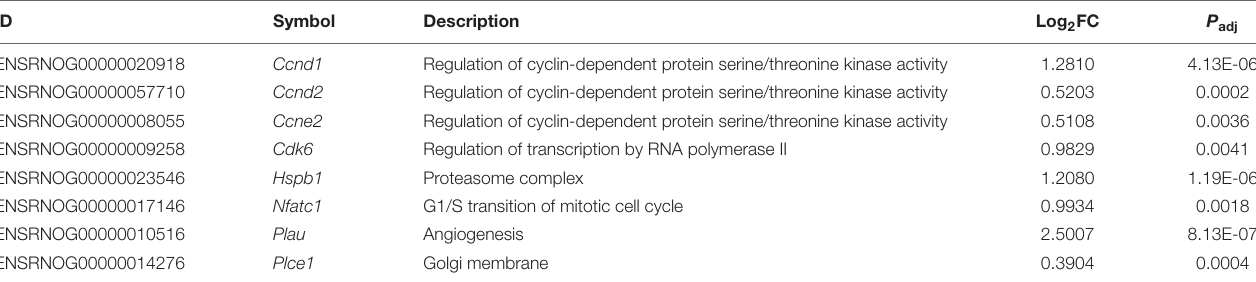
FIGURE 8 | Downstream effector genes related to proliferation and growth were extracted from statistically significant pathways that were detected with SPIA. Eight genes were found to be statistically significant ( P adj < 0.05) in the MSC EPO -treated group. Namely, Ccnd1 , Ccnd2 , Ccne2 , Cdk6 , Hspb1 , Nfatc1 , Plau , and Plce1 . The normalized count data for the expression of each gene was plotted across all groups. TABLE 4 | After performing a pathway topology analysis with SPIA, the 8 downstream effector genes in proliferation and growth, that were statistically significant ( P adj < 0.05) in the MSC EPO -treated group, were extracted and